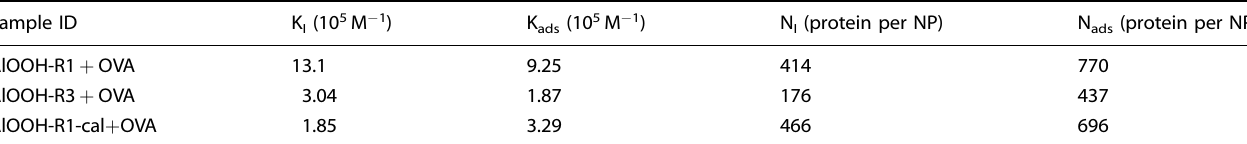
Table 5. Adsorption constants and amounts of adsorbed protein per NP measured by ITC (K I and N I ) and Langmuir adsorption isotherms (K ads and N ads ). Sample ID